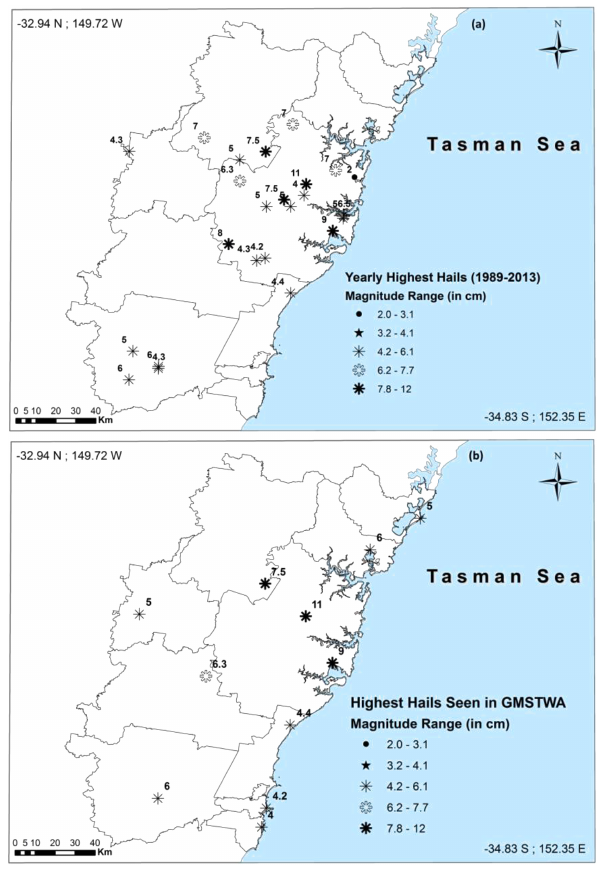
Figure 12. (a) The yearly highest hail events reported from LGAs and (b) the largest hail observed inside the GMSTWA.